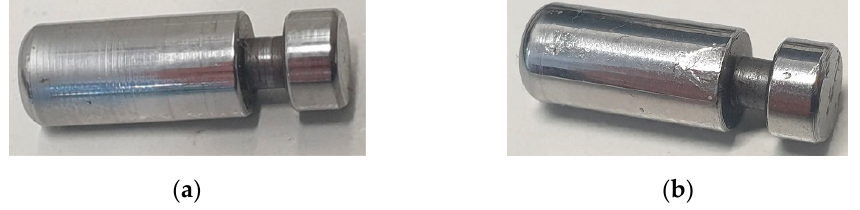
Figure 7. Examples of typical wear behaviors in roller burnishing: ( a ) slightly visible wear marks and ( b ) surface pitting. Source: own-elaboration .